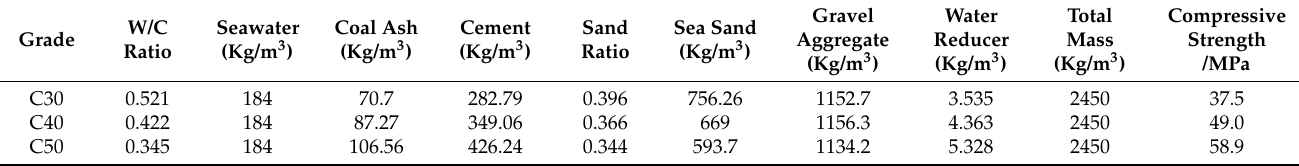
Figure 1. Grain size distribution of sand and gravel aggregate. Table 1. Details of concrete